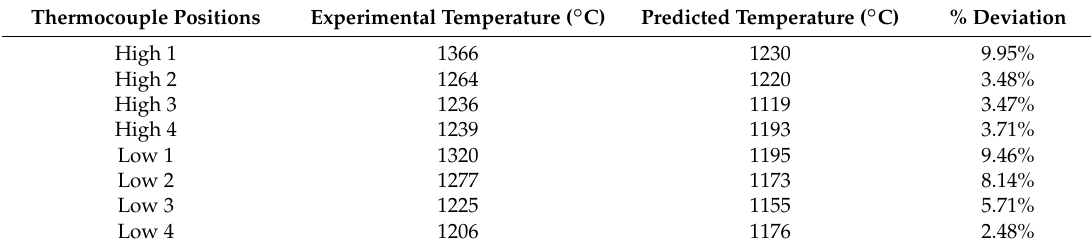
Table 6. Maximum deviation between the CFD predictions and experimental data